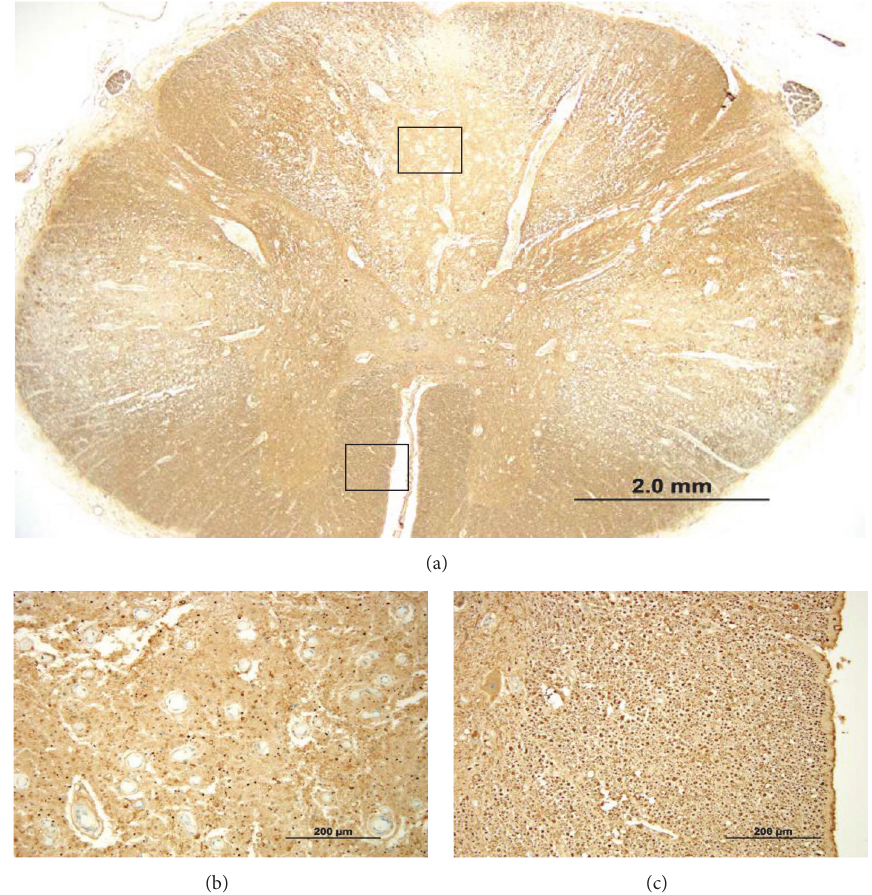
Figure 4: Spinal cord stained immunohistochemically with antibody to neurofilament (NF) demonstrates regional axonal loss; (a) low- power photomicrograph demonstrates areas of axonal loss most pronounced in the dorsal (upper boxed area) and lateral white matter tracts, in contrast to ventral spinal cord (lower boxed area) (original magnification, × 20; NF immunostain); (b, c) higher-power photomicrographs of boxed areas to demonstrate axonal loss in dorsal columns ((b) upper boxed area from (a)) with relative axonal preservation in ventral area ((c) lower boxed area from (a)) (original magnifications, × 200; NF